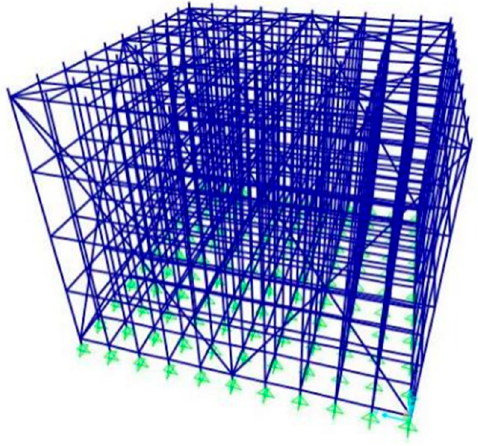
Figure 8. Template support space model.